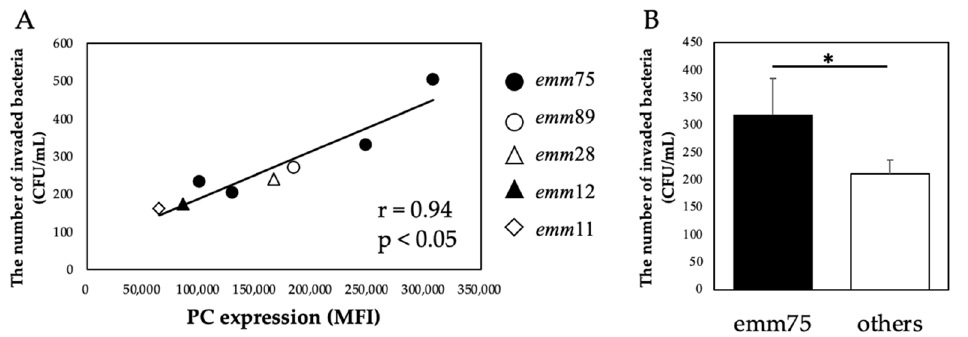
Figure 4. PC expression and bacterial invasion. In Streptococcus pyogenes, PC expression and cell invasion showed a positive correlation (r = 0.94, p < 0.05). ( A ) Furthermore, emm 75 was more invasive than the other types. ( B ) Error bars indicate the standard deviation of the mean ( n = 5). * p < 0.05. MFI, mean fluorescence intensity; PC, phosphorylcholine.